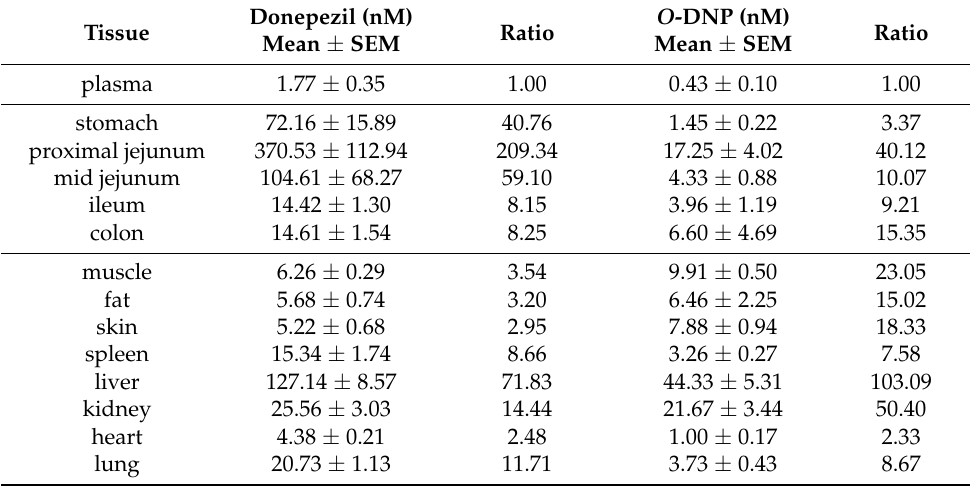
Table 2. Concentrations of donepezil and 6-O-desmethyldonepezil. Concentrations of donepezil and 6- O -desmethyldonepezil ( O -DNP) in porcine plasma and selected organs/body fluids collected 24 h after the last intragastric administration of 10 mg donepezil (on day 8) with preceding 7-day administration of donepezil (5 mg per day) and dextran sodium sulfate (10 g per